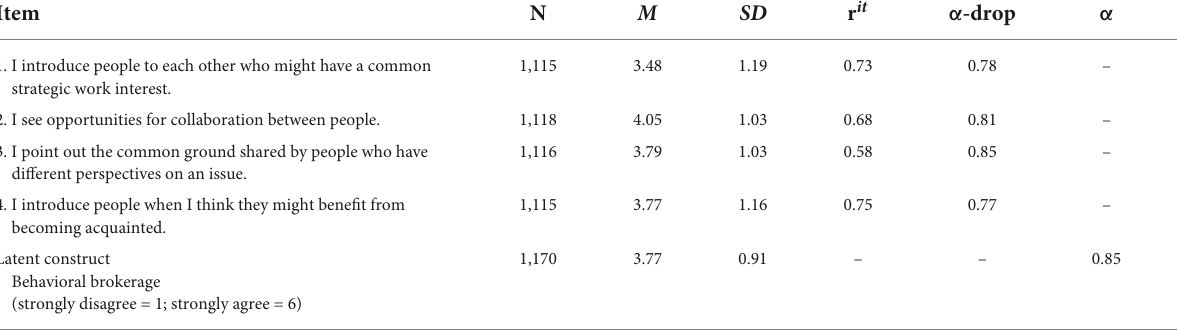
TABLE 1 Measurement instrument to assess school actors’ behavioral brokerage.